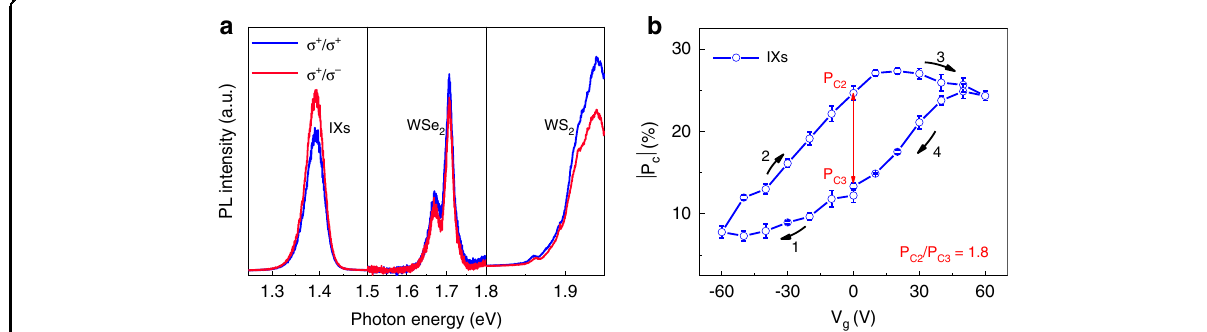
Fig. 4 Electrically-tunable valley polarization of the IXs. a Helicity-resolved PL spectra of the HS under 633 nm excitation (180 μ W) at 78 K. b Absolute circular polarization degree of the IXs as a function of V g . The helicity contrast is de fi ned as P c2 = P c3 , where P c2 and P c3 is the absolute circular polarization degree at 0V-2 and 0V-3, respectively. The error bars in b represent the uncertainty of the data